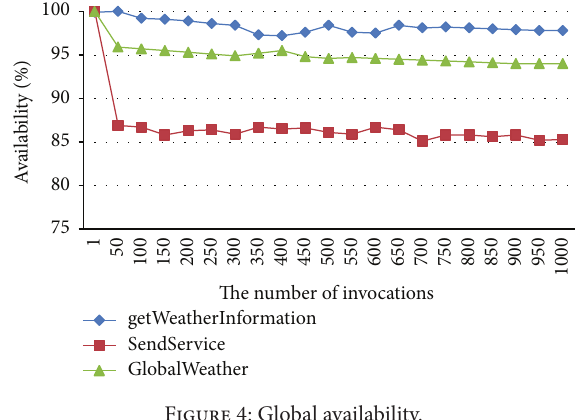
Figure 4: Global